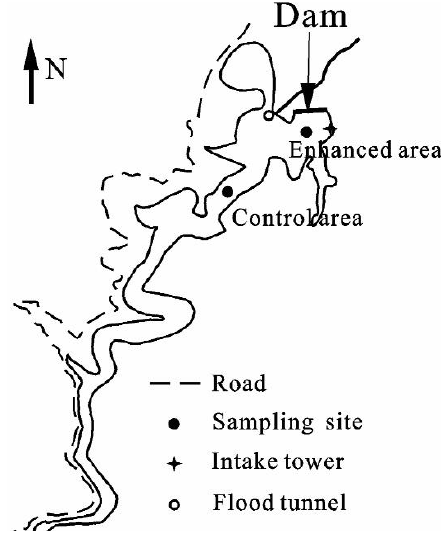
Figure 1. Sampling sites in the enhanced area and control area of Jinpen reservoir.